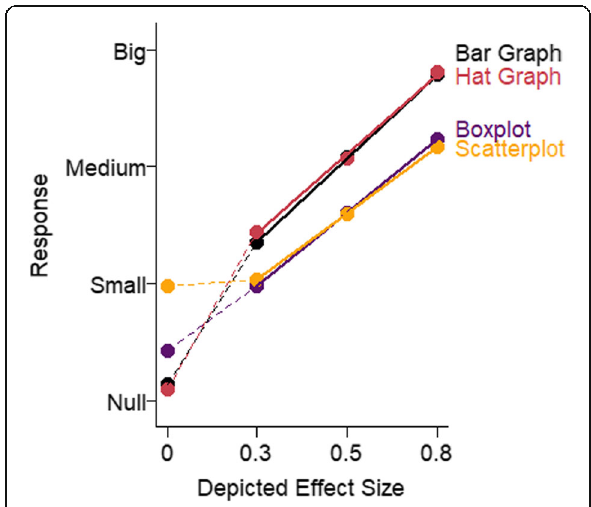
Fig. 17 Mean response is plotted as a function of depicted effect size in the stimuli and graph type for experiment 5 for which feedback was provided. Solid lines represent the mixed linear model coefficients. Steeper lines indicate better sensitivity. The dashed lines connect the mean estimated magnitude of null effects and small effects. The data from the depicted null effects were not included in the